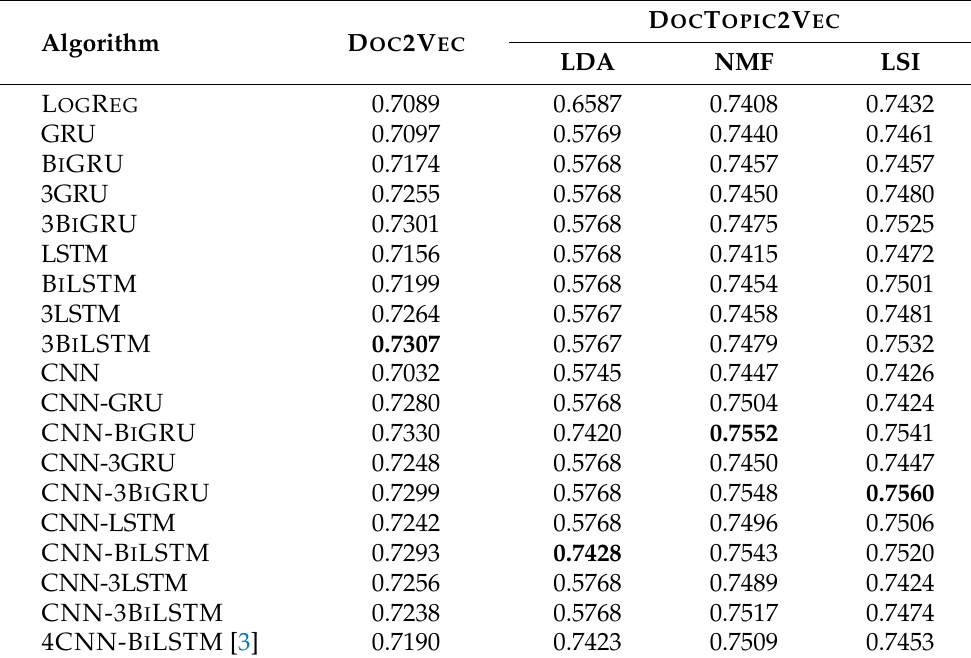
Table 10. Experiments using the G LO V E embeddings of size 128. (Note: Bold marks the best accuracy obtained for the combination of Algorithm and